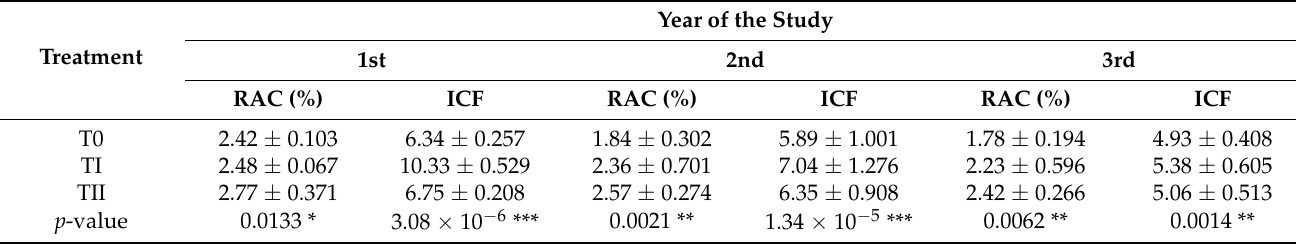
Table 3. Risk assessment codes (RAC) and individual contamination factors (ICF) assessed for soil depending on treatment and year of study (mean values).